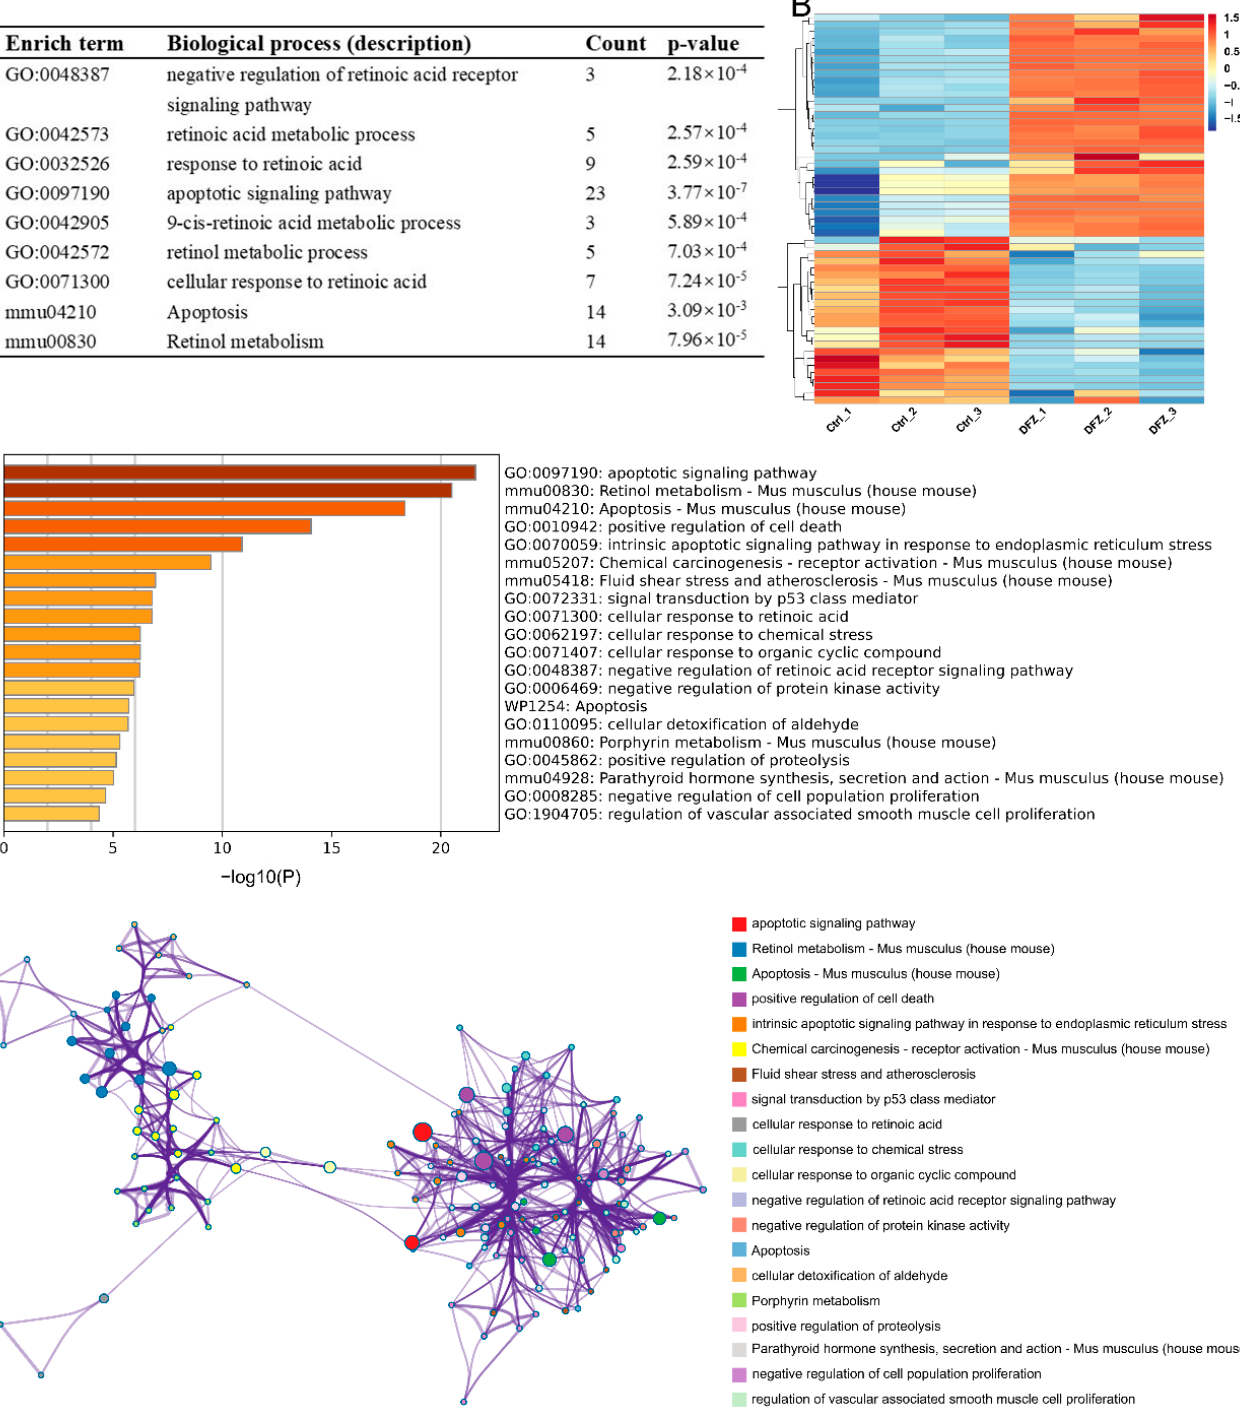
Figure 6. Bioinformatics analysis of the transcriptomic data of GC-2 cells in control and DFZ exposure groups. ( A ) Enriched terms related to RA pathway and apoptosis. ( B ) Heatmap, ( C ) Ontology clusters, and ( D ) network of DEGs enriched in RA pathway- and apoptosis-related terms.